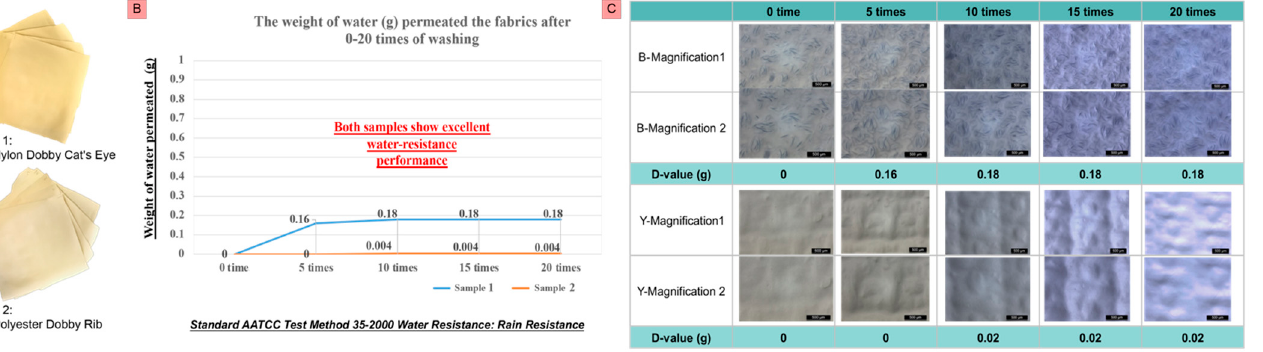
Figure 2. ( A ) Samples for waterproof pad; ( B ) The results of water-proof test; ( C ) SEM images of different washing circles.